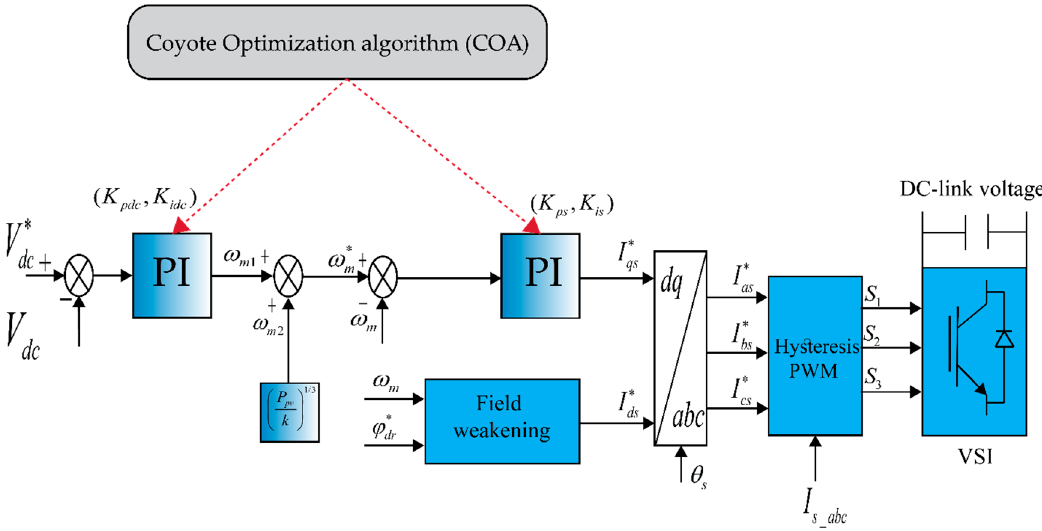
Figure 6. Proposed metaheuristics-tuned proportional-integral (PI) controllers for the solar photovoltaic water-pumping system (SPVWPS).